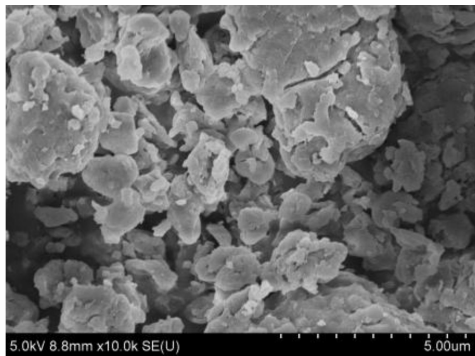
Figure 3. Morphologies of biomass particles (magnification of